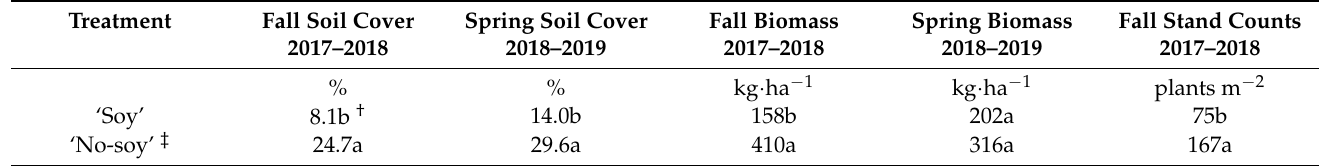
3.1.2. Cover Crops Fall and Spring Coverage and Biomass in Treatments with No Soybean (‘No-Soy’) Winter camelina had lower cover percent and biomass compared with rye in both the fall and the spring (Table 7). Winter camelina had a slower establishment period, which set the plant behind compared with rye. Rye had higher soil coverage and biomass compared with camelina biomass, as was also reported in other research [15,20,21]. while winter camelina had more plants compared with rye. Rye produced only some tillers in the fall. and camelina stayed in the rosette stage and had limited foliar growth. Table 7. Mean fall and spring cover crop soil cover, cover crop biomass. and cover crop stand counts for two cover crops averaged across conditions and environments at Fargo and Casselton, ND, 2017, 2018, and 2019. Cover Crop Fall Soil Cover Spring Soil Cover